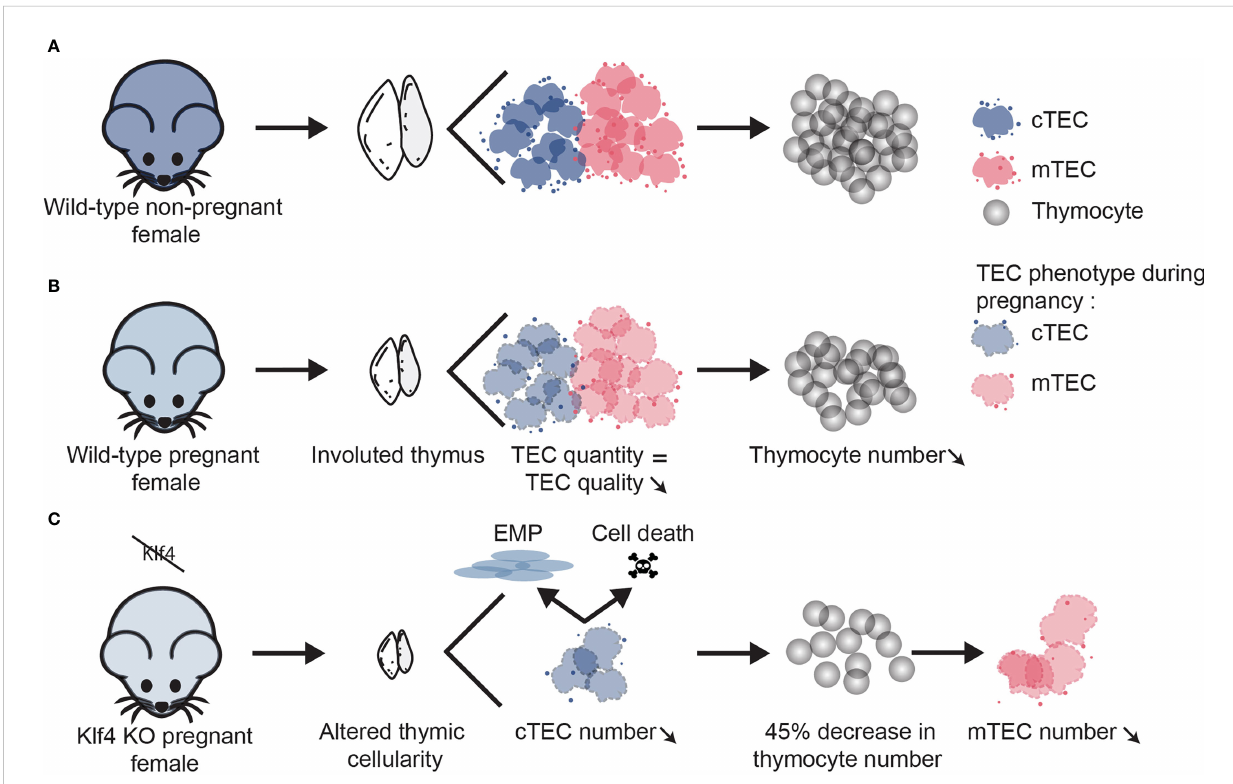
FIGURE 8 Klf4 is a protective factor for thymus integrity during pregnancy-associated thymic involution. Working model depicting the role of Klf4 in TEC homeostasis during late pregnancy. (A) Non-pregnant WT mice exhibit an age-appropriate level of TEC and thymocyte numbers. (B) During late pregnancy, thymocyte hypocellularity in WT mice is associated with functional defects in TECs without TEC loss. (C) When Klf4 is deleted, cTEC apoptosis and EMP deplete the cTECs pool. As a result, thymocyte loss is aggravated, particularly for the SP thymocytes. Loss of SP thymocytes leads to a decrease in mTEC